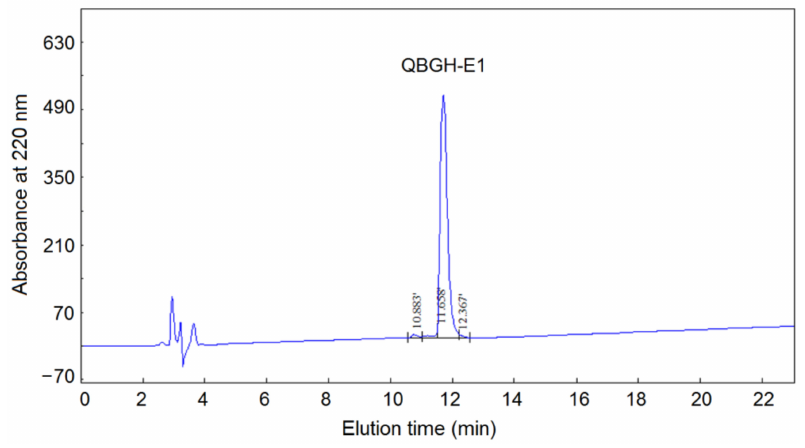
Figure 2. Reversed-phase high-performance liquid chromatography profile of subfraction QBGH-E